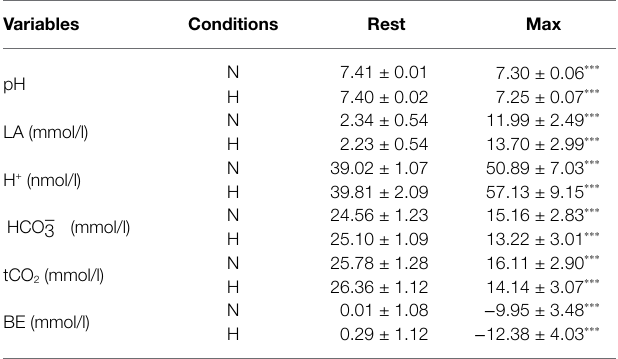
TABLE 1 | Acid–base balance before and after 30 km time trial in normoxia (N) and hypoxia (H).